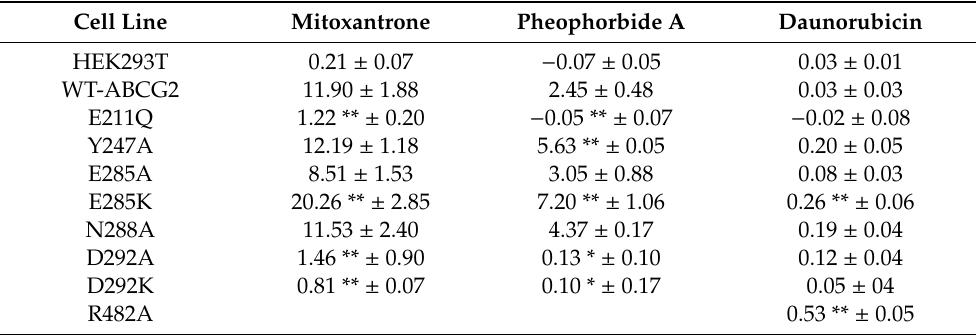
Table 1. Ko143-inhibited transport of fluorescent drugs by NBD interface mutant isoforms. The table depicts the mean (with standard error of the mean) of the fractional di ff erence in Ko143-inhibited drug e ffl ux compared to the wild type. The raw data for mitoxantrone and pheophorbide A were processed using one-way ANOVA and a post statistical test (Dunnett’s multiple comparison) against the wild type. The data for the daunorubicin e ffl ux were subjected to log transformation due to positive skewed data for R482A mutant isoform, prior to analysis of significance. The data are representative of n ≥ 3 independent repeats. Asterisks indicate the level of significance with p ≤ 0.05 for * and p ≤ 0.01 for ** compared to wild type